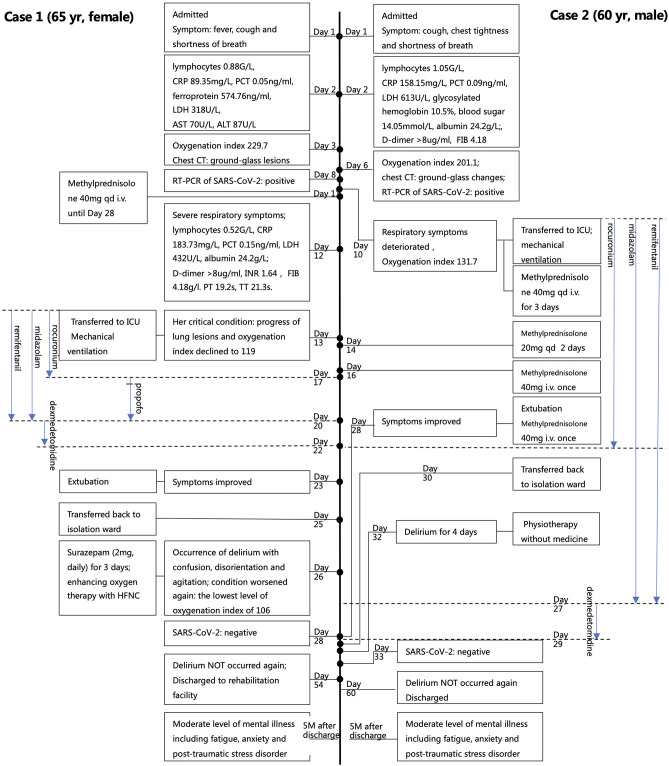
Time-line of main events of two patients. Numbers in the middle line represents the days in hospital. Lymphocytes 1.1–3.2 G/L, CRP 0–8 mg/L, PCT <0.05 ng/ml, Ferroprotein 21.81–274.66 ng/ml, LDH 109–245 U/L, AST 8–40U/L, ALT 5–40 U/L, Albumin 33–55 g/L, Glycosylated hemoglobin 4–6%, Blood sugar 3.9–6.1 mmol/L, D-dimer 0–0.5 ug/ml, PT 11.0–16.0 s, APTT 27.0–45.0 s, INR 0.83–1.36, FIB 2.00–4.00 g/l, TT 14.0–20.0s, Oxygenation index 400–500 mmHg. HFNC, High-flow nasal cannula oxygen therapy.